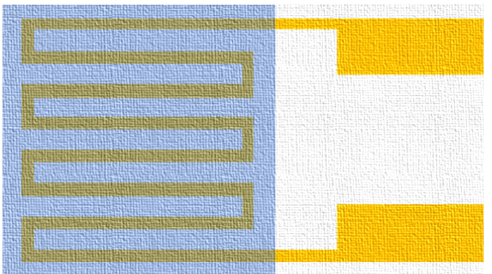
Figure 4. Schematic diagram of resistive micro humidity sensor.